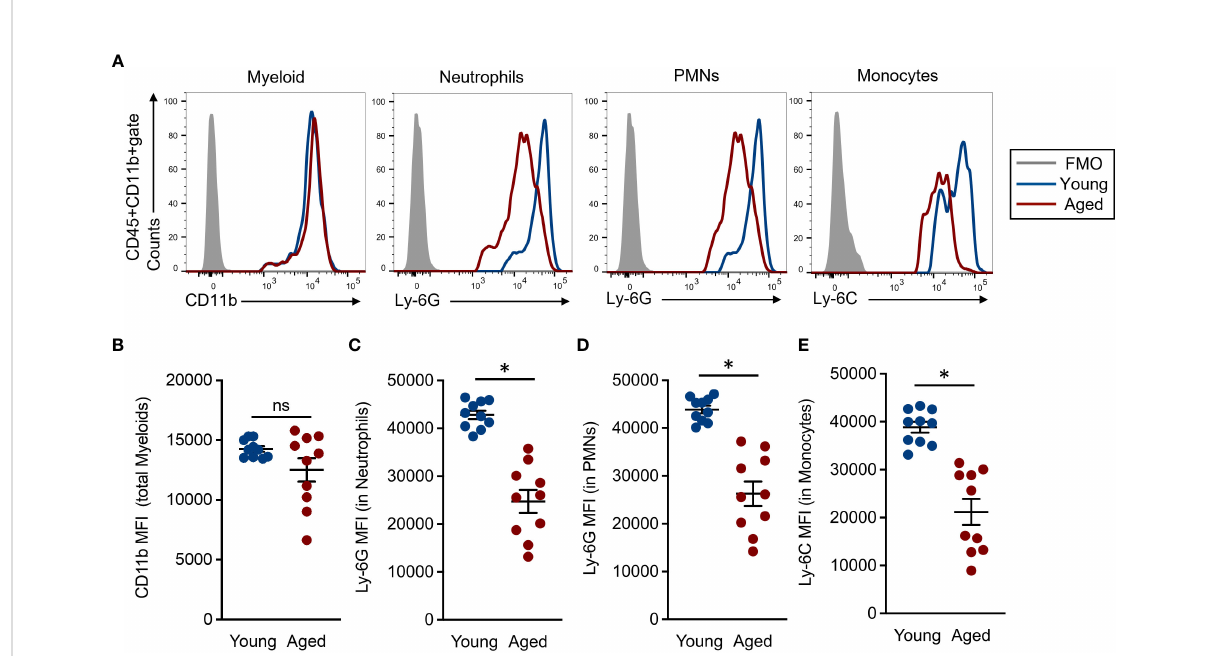
FIGURE 2 Comparison of common myeloid marker expression in each cell population (A) Representative histograms in fl ow cytometry analysis. Each population was determined by following the gating strategy represented in Supplemental Figure 2. (B) CD11b MFIs in the total myeloid population. (C, D) Ly-6G MFIs in granulocyte (C) and PMN (D) populations, respectively. (E) Ly-6C MFIs in the monocyte population. The cumulative data are shown as mean ± SEM values of 10 samples. Student ’ s t -test was used to analyze data for signi fi cant differences. Asterisk indicates signi fi cance: * p < 0.01. ns; not signi fi